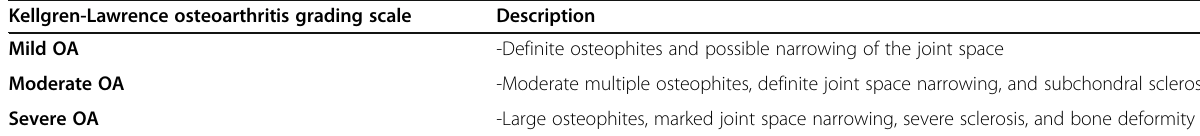
Table 1 The Kellgren-Lawrence radiographic osteoarthritis grading